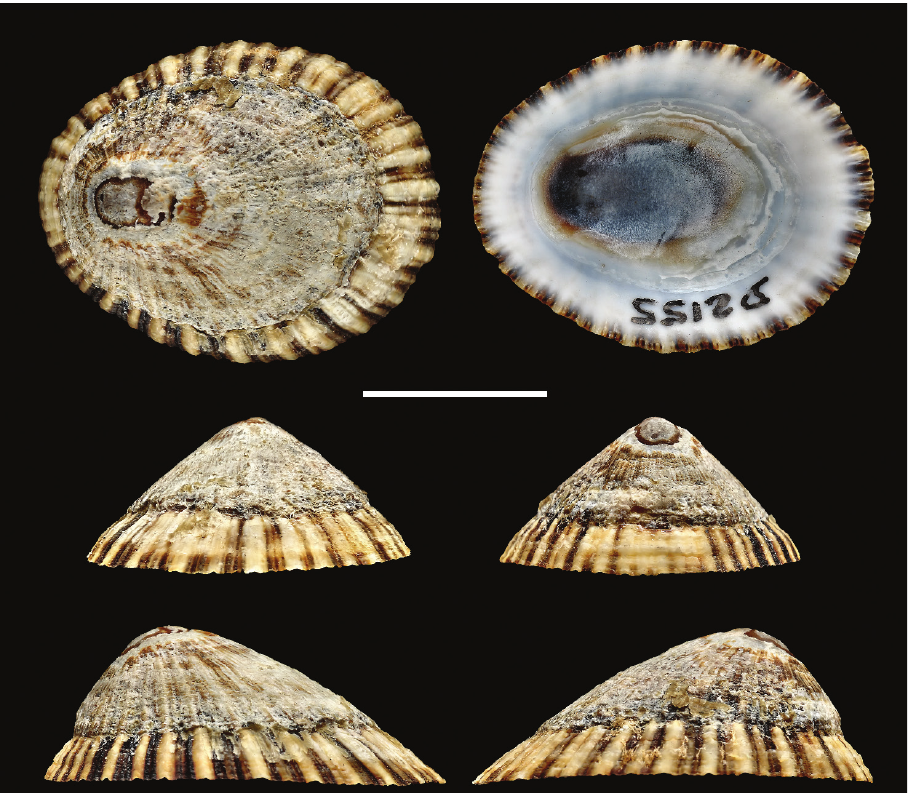
Figure 1. Patella aphanes Robson, 1986. Holotype T3285/NMSA-MOL 0D2155. Scale bar: 10